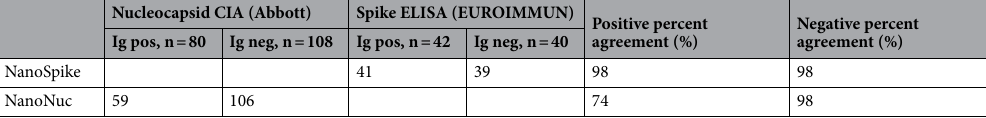
Table 1. Comparative analysis of NanoSpike- and NanoNuc-mediated hemagglutination tests. Hemagglutination assays based on serum from COVID-19 convalescent and control patients was performed using NanoSpike and NanoNuc and directly compared to results obtained from the Nucleocapsid CIA (Abbot) and Spike ELISA (EUROIMMUN), respectively. Hemagglutination assay controls, i.e. NanoControl and NanoLink were included to aid visual test